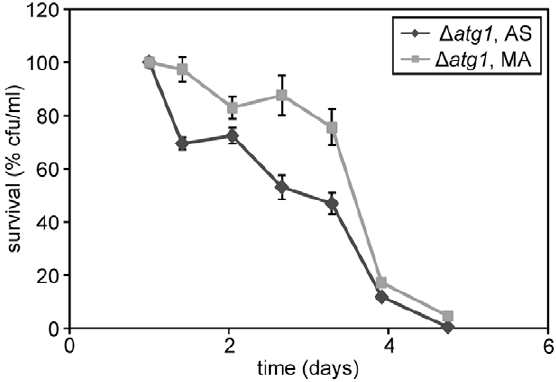
Figure 3. Chronological aging of H.polymorpha D atg1 cells. CLS of D atg1 cells grown on methanol in the presence of AS or MA. Bars indicate the standard error of mean of four experiments.